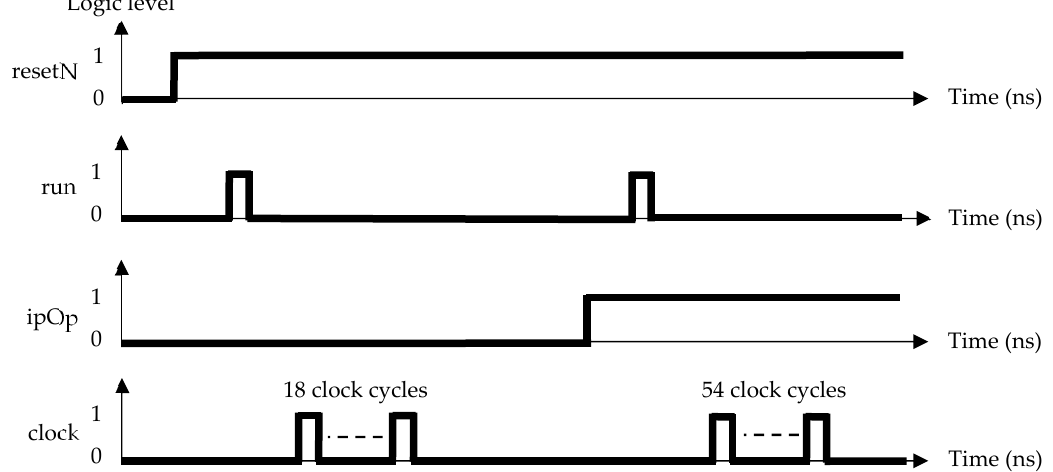
Figure 5. Computation control signal timing diagram.